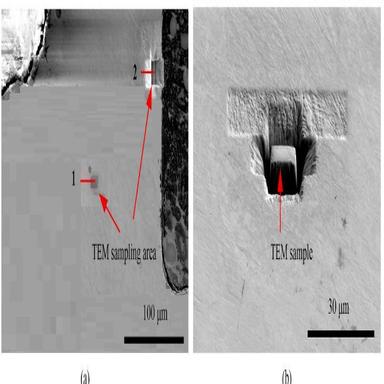
Photos of TEM sample preparation. (a) Sampling areas for TEM observations, in which the areas 1 and 2 indicate the typical areas of PSZ and SDZ, respectively. (b) Experimental photo of sampling by using focused ion beam technology.